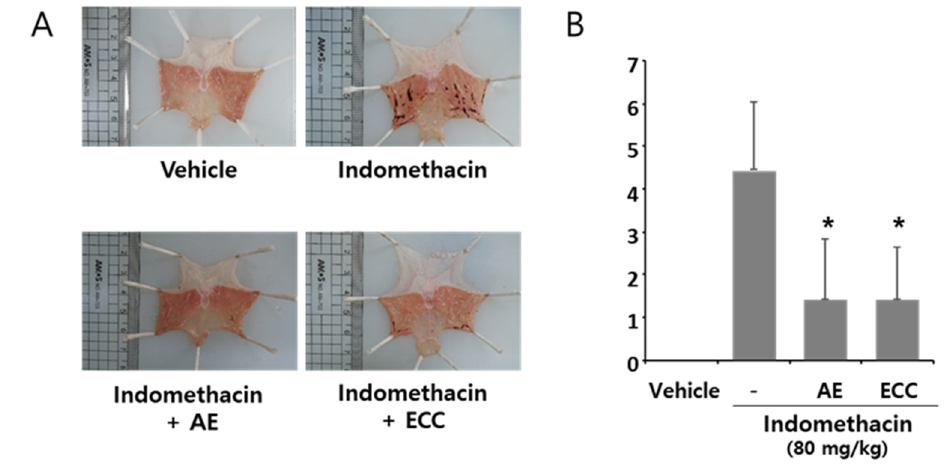
Figure 9. Ameliorating effect of ECC on gastric damage in rats. Forty rats were fasted for 48 h before the experiment. Experimental groups were treated with ECC (24 mg/kg) or AE (20 mg/kg) for 30 min and then with indomethacin (80 mg/kg). All the treatments were administrated orally. Five hours later, all animals were sacrificed, and their stomachs were harvested to measure the damaged areas. ( A ) Representative pictures of stomachs from each group. ( B ) Statistical analysis of the damaged areas. The data represent from values from 10 repeated experiments. * p < 0.05 compared to the indomethacin group.